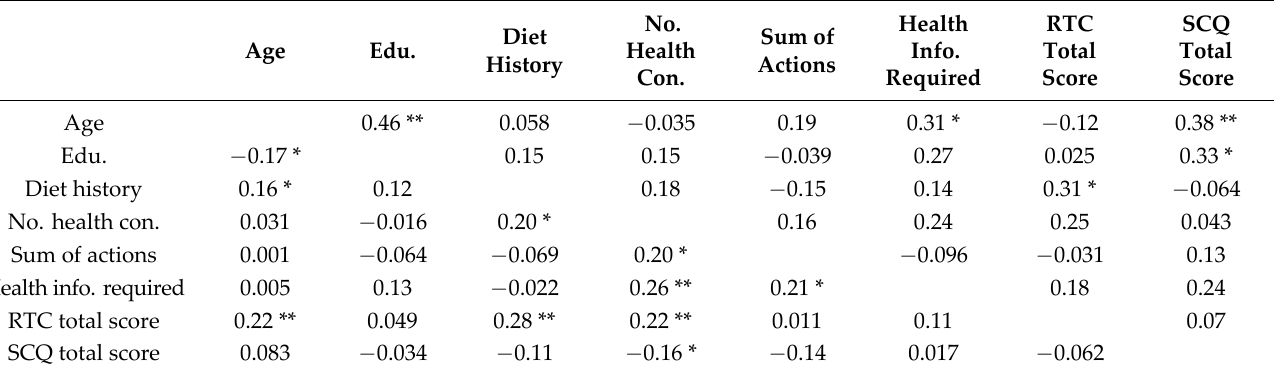
Table 5. Correlation matrix of age, education, dieting history, number of health‑related concerns, to‑ tal actions to be taken, further information required, Readiness to Change total score, and Situational Confidence Questionnaire total score, separately for females and males.